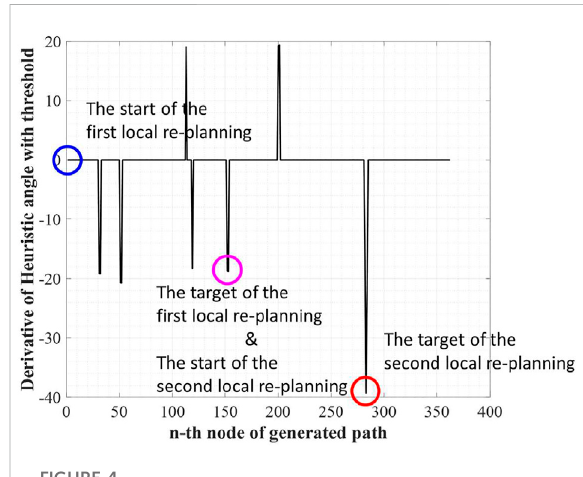
FIGURE 4 The start and the target for local replanning of the example.